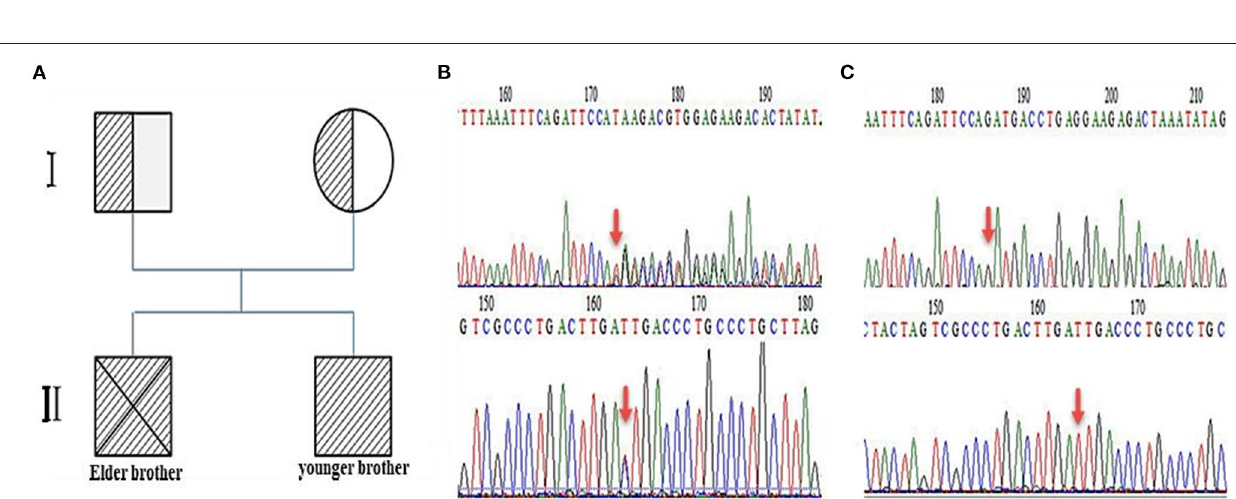
was regularly followed on an outpatient basis every month for liver and kidney function tests, VLCFA examinations, and chimerism tests. Brain MRI and hearing tests were repeated every